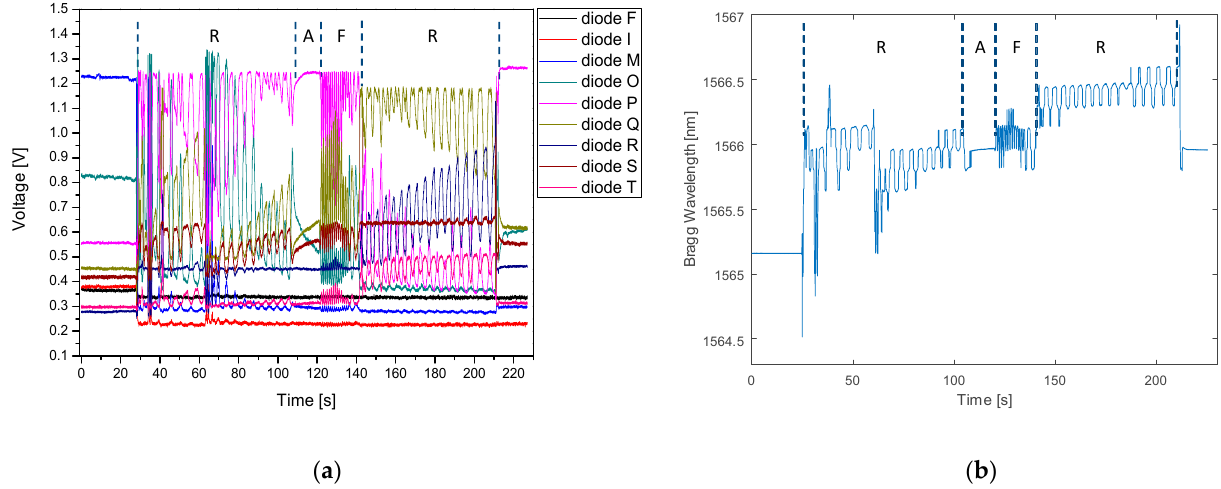
Figure 14. Result of measurement with person lying on the mattress and changing breathing pace: regular breathing (R), apnea (A), fast breathing (F) and regular breathing (R), captured by ( a ) PIC interrogator; ( b ) Ibsen I-MON 256 interrogator. Effect of FBG heating up is visible also.